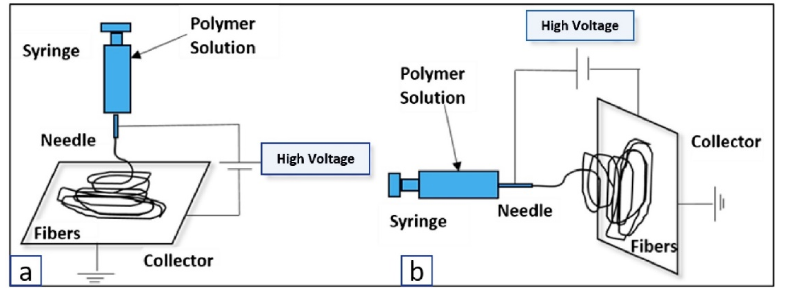
Figure 3. Electrospinning setup for fibrous mesh formation, shown using both ( a ) vertical and ( b ) horizontal spinning [105].